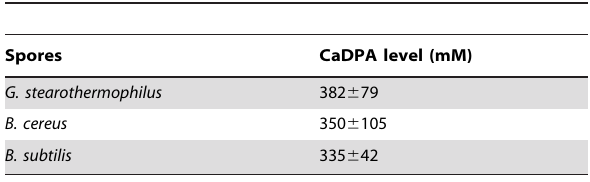
Table 1. CaDPA level in individual G. stearothermophilus and Bacillus